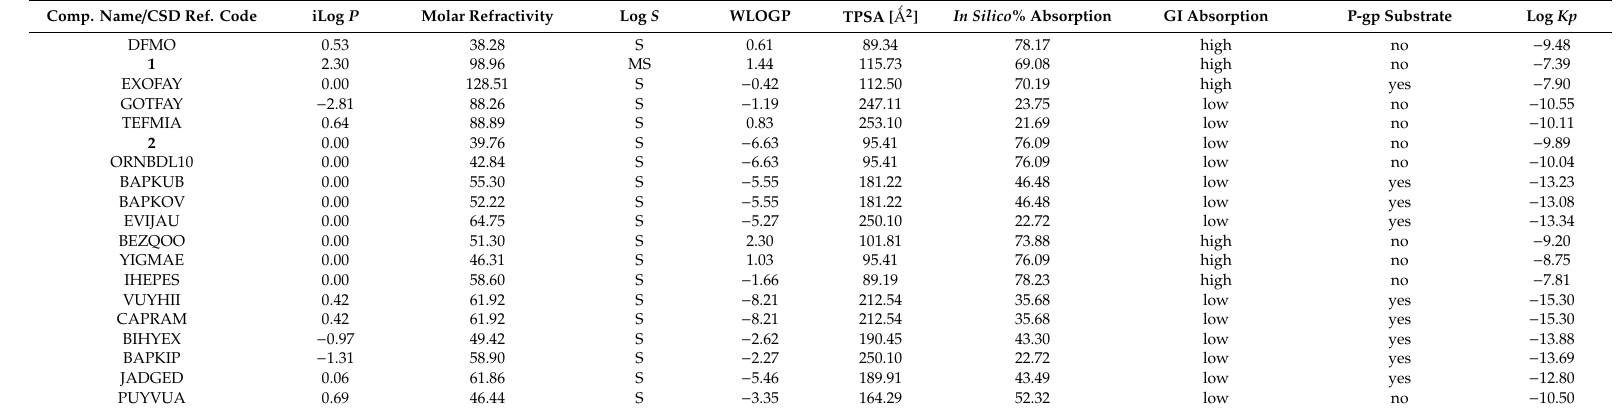
Table 4. Selected physicochemical and pharmacokinetic properties of the analyzed compounds.